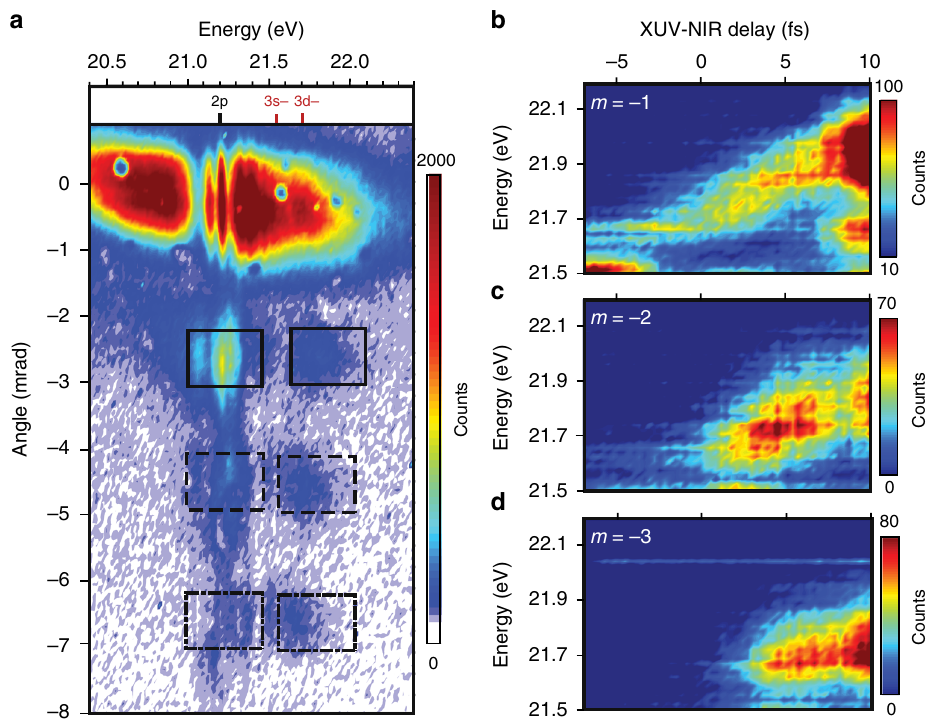
Fig. 2 Order-dependent AC Stark shift of the 3d − light-induced state. a The experimental charge-coupled device (CCD) camera image taken 3.5 fs after overlap and cropped to emphasize the redshift of the light-induced state (LIS) spectra with grating order. The energy and delay dependence of the LIS emission features associated with the b m = − 1, c m = − 2, and d m = − 3 grating orders are obtained by integrating vertically (0.7 mrad) over the three highest energy black boxes in a . The selected regions were chosen to avoid contamination from the distorted 2p state and allow for the full breadth of the energy